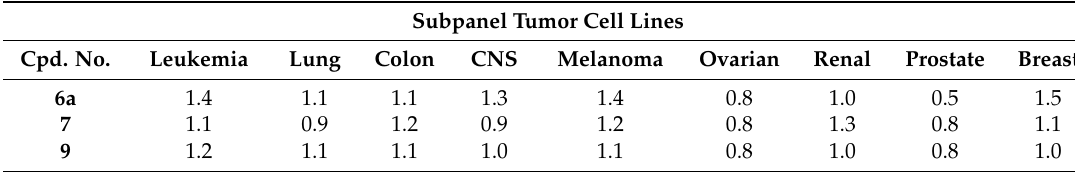
Table 6. Selectivity ratios for compounds 6a , 7 and 9 towards the nine tumor cell lines. Subpanel Tumor Cell